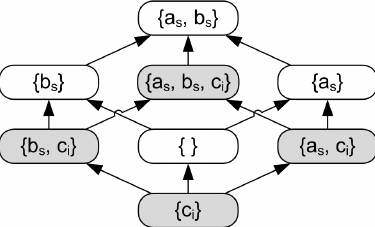
Figure 4. Label-based lattice. This example includes 2 secrecy tags a s and b s and one integrity tag c i . Boxes represent service labels. Grey boxes show labels including c i . Arrows link labels between which information can